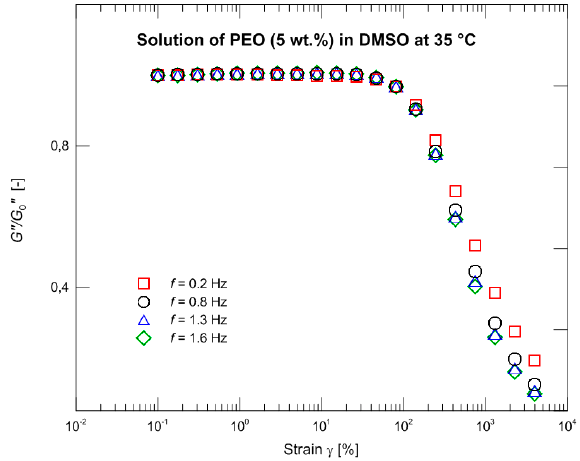
Figure 3. Normalized loss modulus as a function of strain.